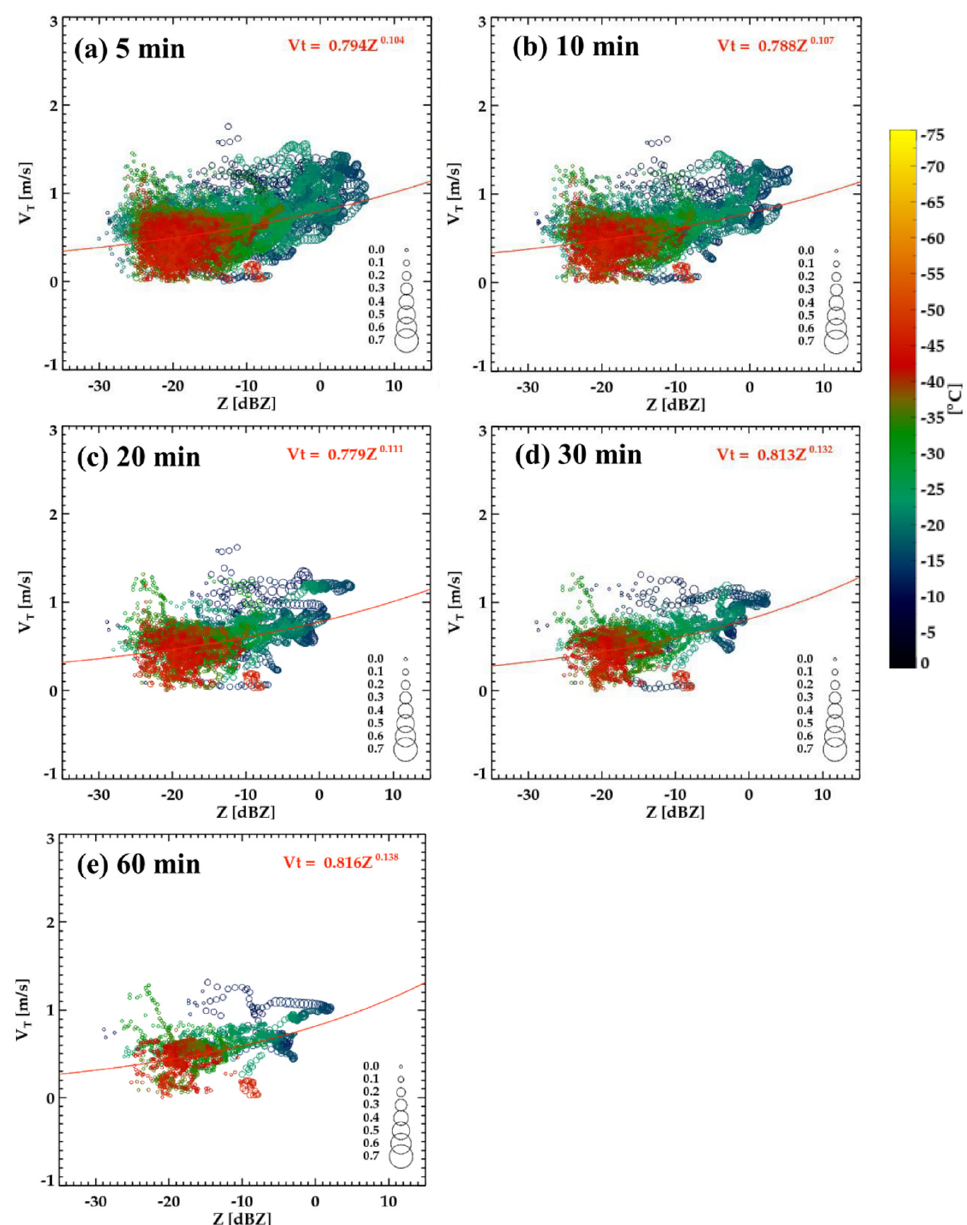
Figure 8. Scatterplots of terminal velocity ( V t ) as a function of Z for a case of cirrus on 25 September 2014 as a function of average window sizes: ( a ) 5 min, ( b ) 10 min, ( c ) 20 min, ( d ) 30 min, and ( e ) 60 min. The red lines are fitted V t – Z relationships. The circles indicate SW, and the color is atmospheric temperature from sounding measurements.